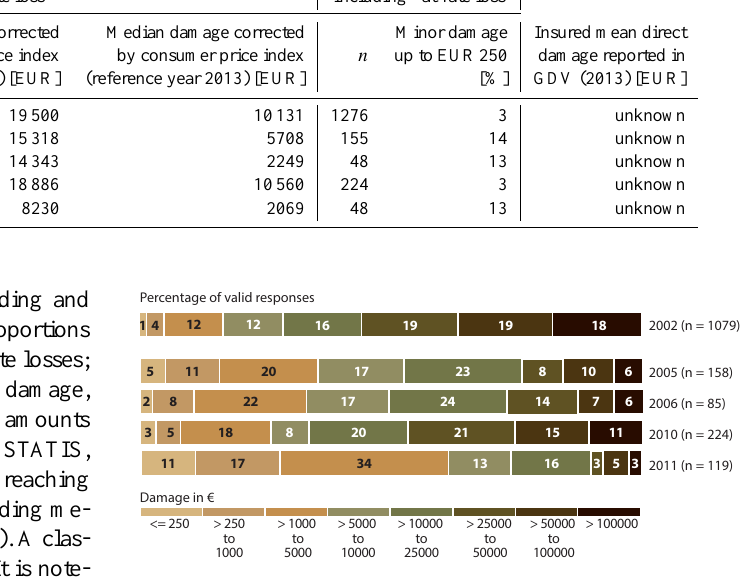
Figure 7. Classified damage to residential buildings (excluding mi- nor damage flat-rate), prices as of June 2013.